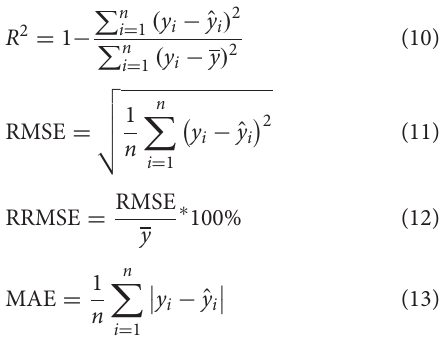
TABLE 3 | Candidate hyperparameters for elastic net